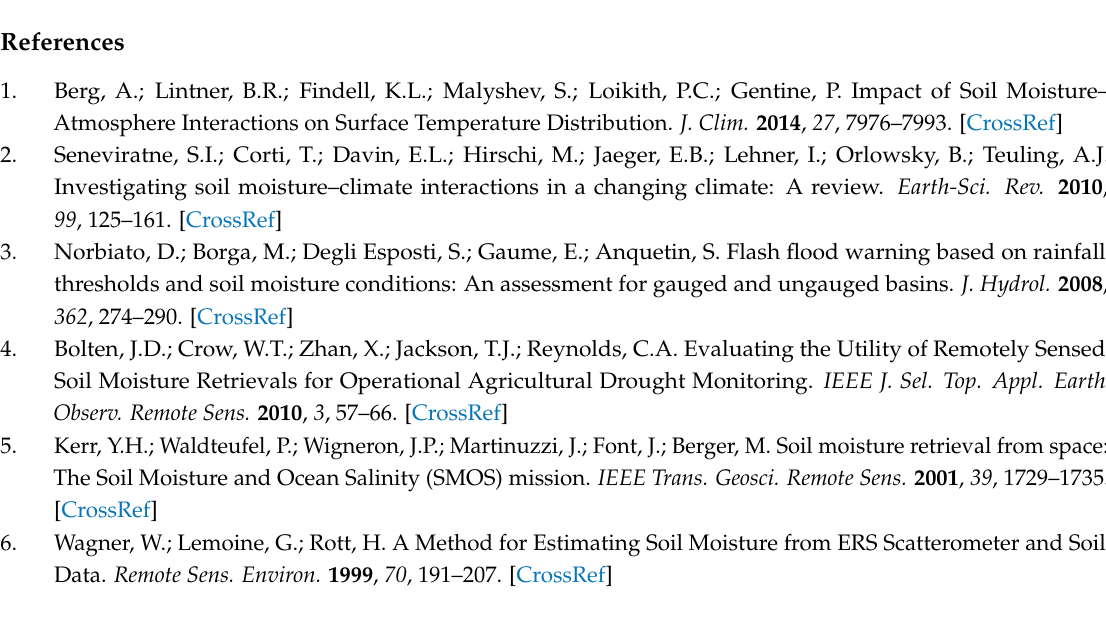
s1, Figure S1: The AQUI in situ stations distributed in the “contributing area” for a single grid point for SMOS, ASCAT, and CCI, Table S1: Same as Table 5 but using only overlapping dates, Table S2: Same as Table 6 but using only overlapping dates. Table S3: Same as Table 7 but using only overlapping